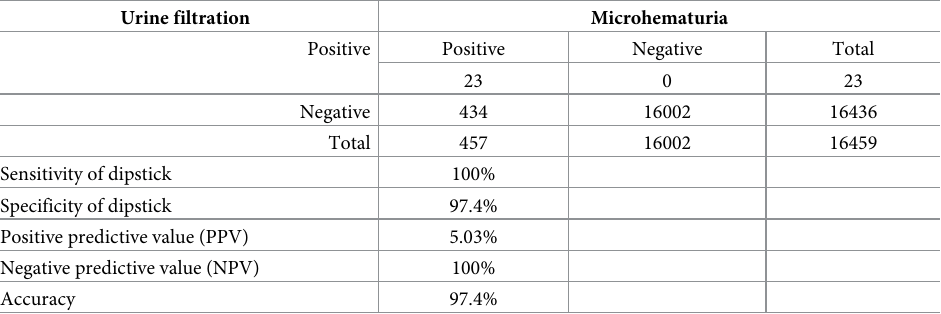
Table 1. Sensitivity, specificity and predictive values of the reagent dipstick method for S haematobium in study participants when filtration results are considered reference